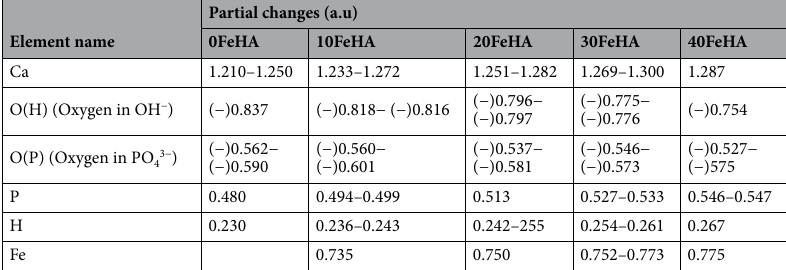
Table 3. Partial charges on different atoms in undoped and Fe-doped HA, calculated using charge equilibration (Qeq) method 49